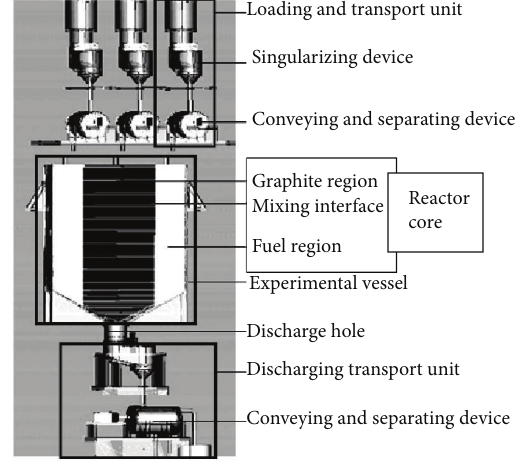
Figure 1: Experimental installation at INET of Tsinghua University and sketch of the two-region arranged reactor core.